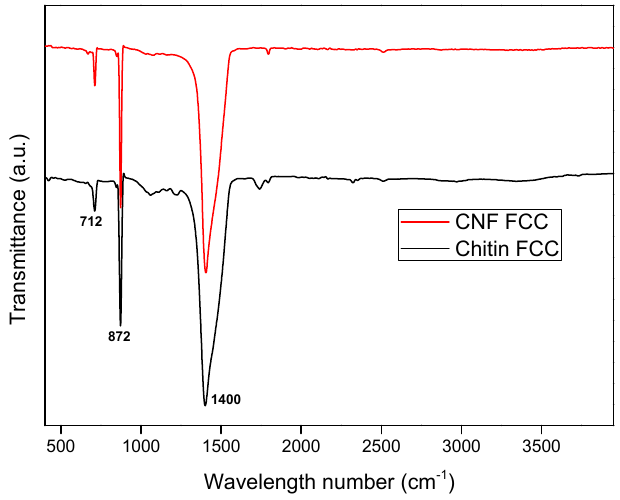
Figure 3. FTIR spectra of the prepared FCCs from ChMF and CNF.